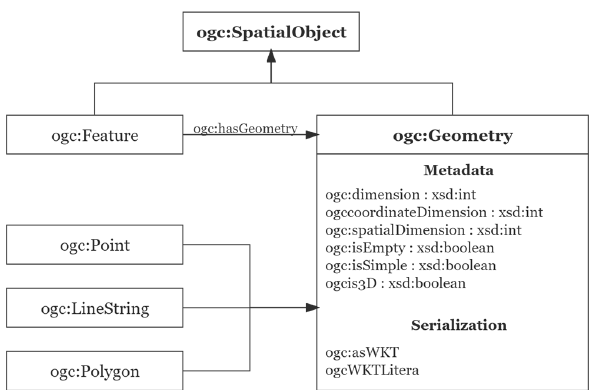
Figure 5. GeoSPARQL part of the ontology table.